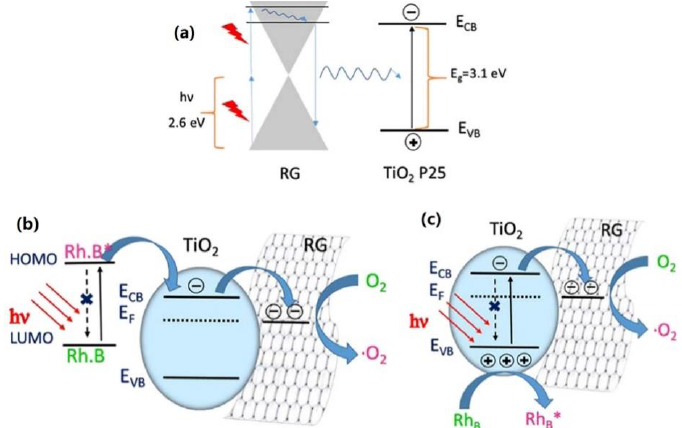
Figure 2. Photocatalytic mechanisms of graphene-TiO 2 composite under ( a ) visible light ( b ) UV light. Reprinted with permission from [54]. Copyright 2013, Elsevier.